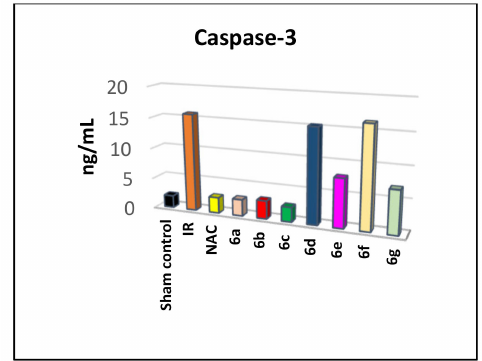
Figure 7. Caspase-3 level (ng / mL) in the serum of testicular I / R rats treated with compounds 6a – g and NAC.